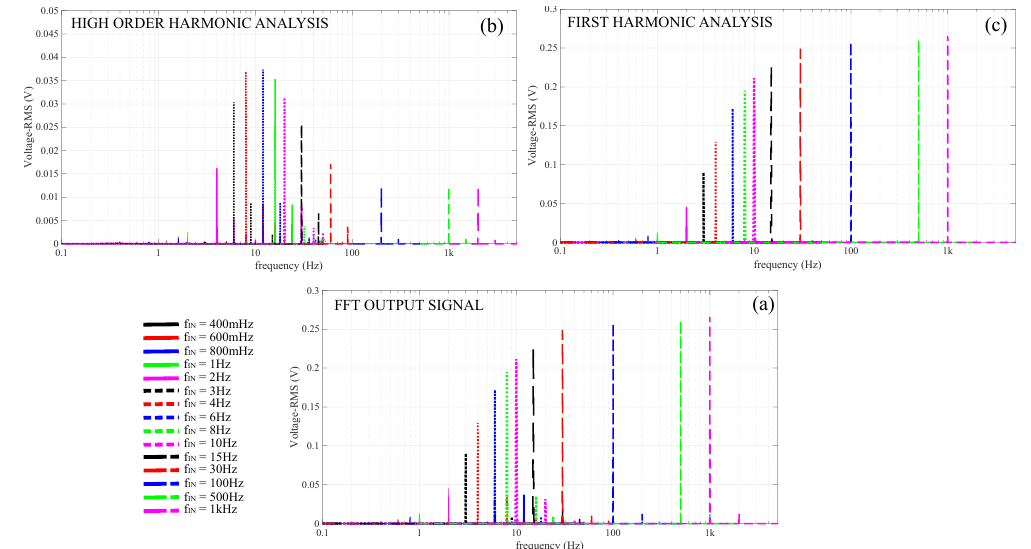
Figure 25. Characterization of the LL-PFGA non linear behaviour around the low cut-off frequency. C IN = 100 nF. Frequency sweep in the range [0.1 Hz,1 kHz]. ( a ) Total spectrum of the amplifier output signal. ( b ) Harmonics generated by the non linearities of the LL-PFGA. ( c ) Fundamental